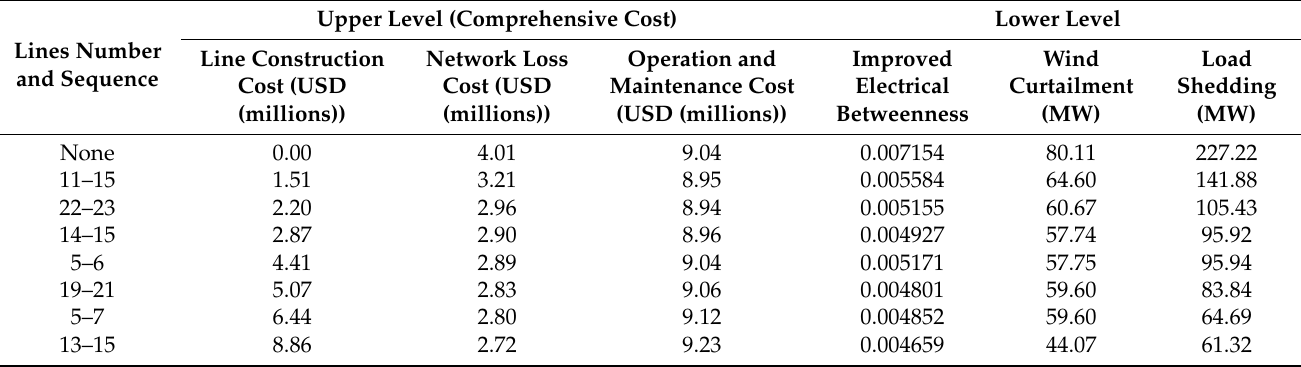
Table 10. TNEP scheme of DQN in modified IEEE RTS-24 bus system under unavoidable interference.